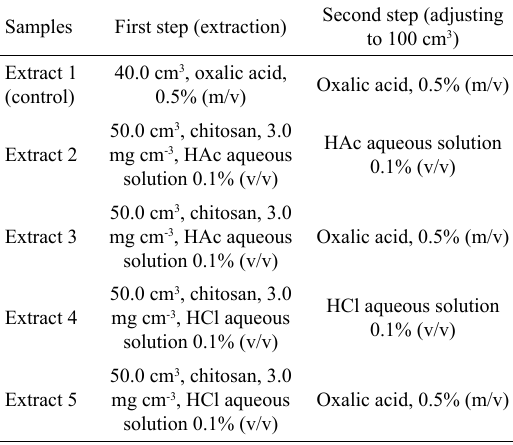
Table 1. Different systems used to extract vitamin C from the agroindustrial byproduct of acerola.